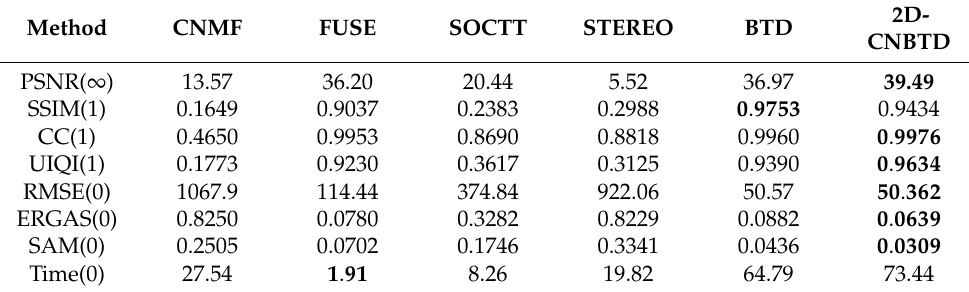
Table 4. Performance for GF-1 and GF-5 sand lake in Ningxia of China.